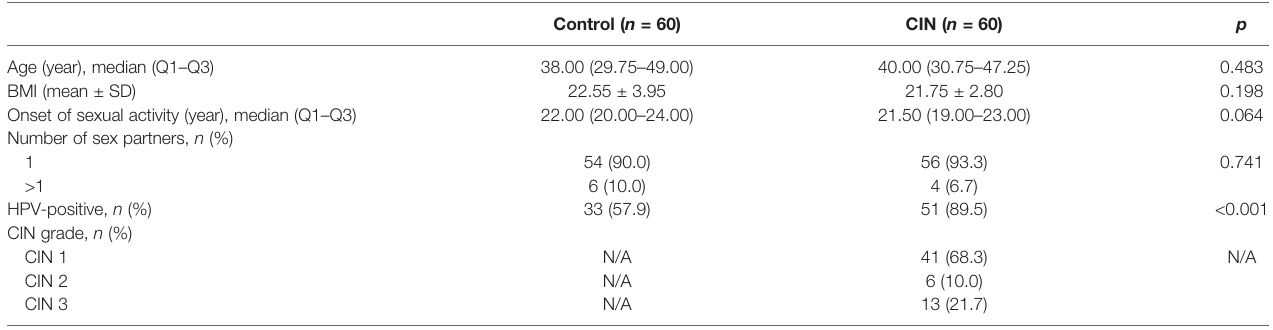
Q1, the fi rst quantile; Q3, the third quantile; SD, Standard Deviation; CIN, cervical intraepithelial neoplasia; BMI, body mass index; CIN, cervical intraepithelial neoplasia; HPV, human papillomavirus. N/A means data